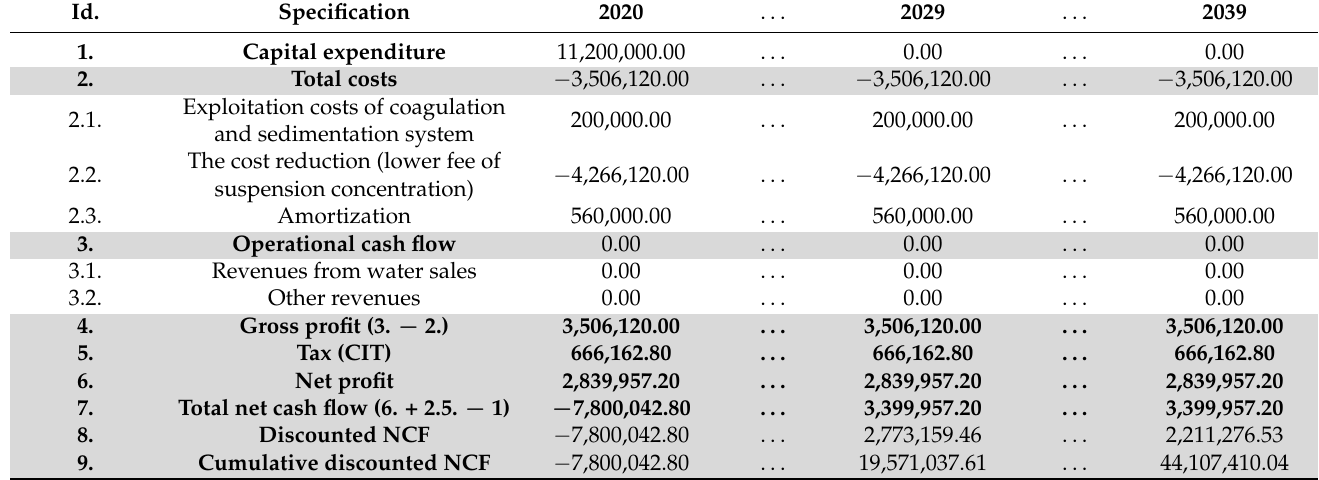
Table 3. Cash flows in Variant 2 (TSS concentration = 500 mg/dm 3 ).